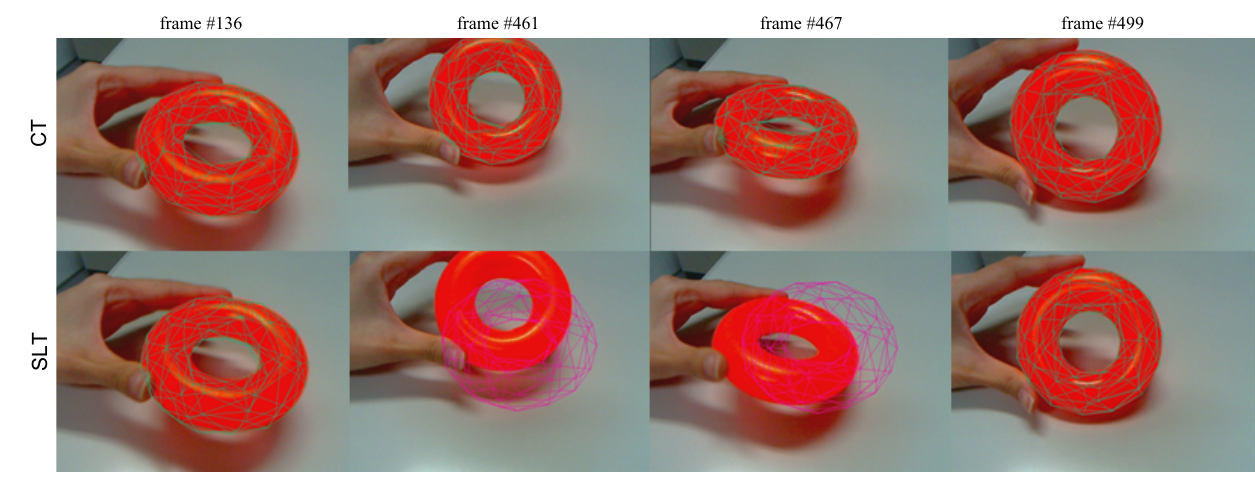
Fig. 16. Qualitative evaluation for the torus. In the upper sequence, CT does not present any failure. In the bottom sequence, SLT fails in some poses.